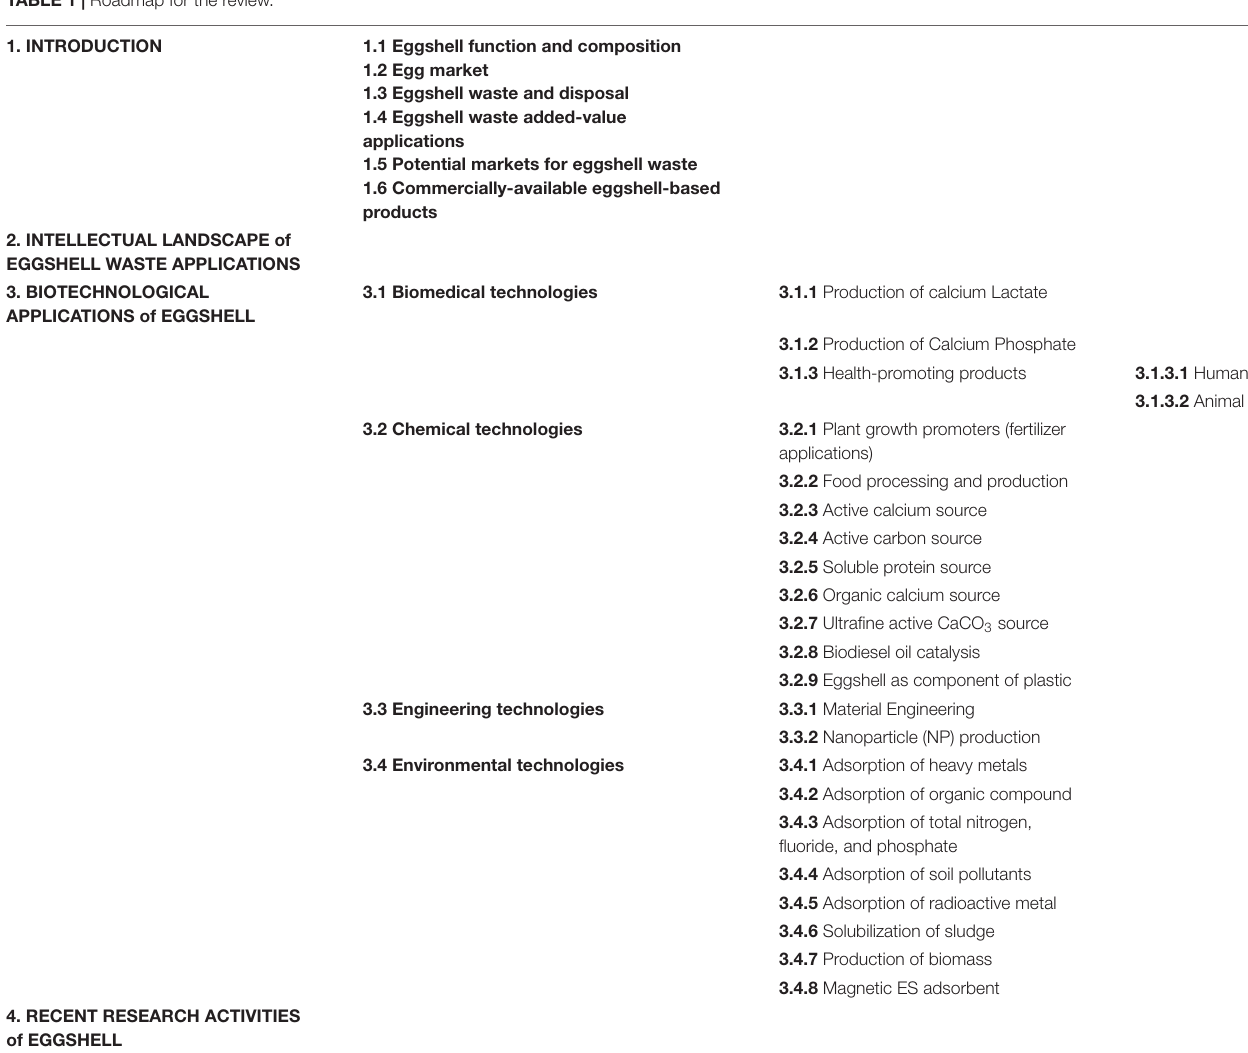
TABLE 1 | Roadmap for the